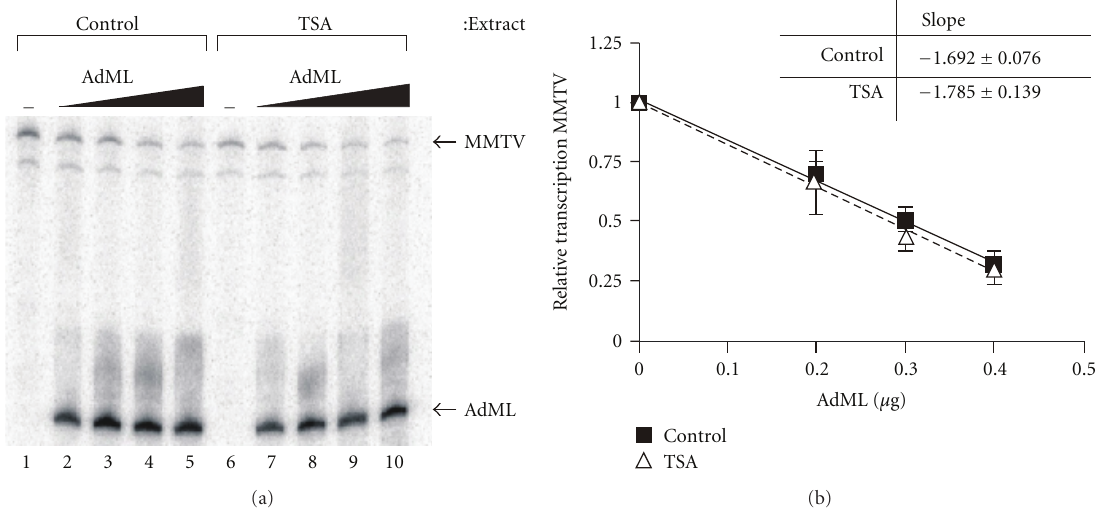
Figure 6: HDAC inhibition does not a ff ect the stability of initiation complexes at the MMTV promoter as determined by template competition assay. Transcription of the MMTV template in extracts from control or TSA-treated cells was carried out in the presence of increasing amounts of AdML template. A representative experiment is shown in (a). (b) shows the relative level of MMTV transcription in extracts from either control or TSA-treated cells. Transcriptional levels in each extract are expressed relative to those measured in the absence of AdML template. The results shown are derived from at least 3 independent experi ments. The data were subjected to linear regression analysis to generate lines and slopes using GraphPad Prism. Error bars represent